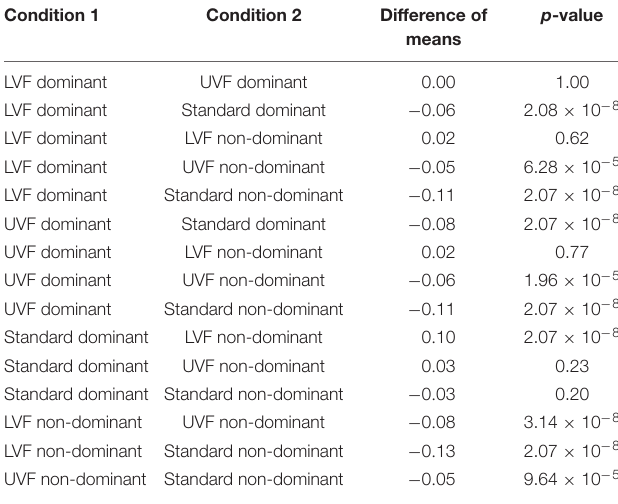
TABLE 1 | Results from post hoc Tuckey for the degree of multifractality (cid:49) H15